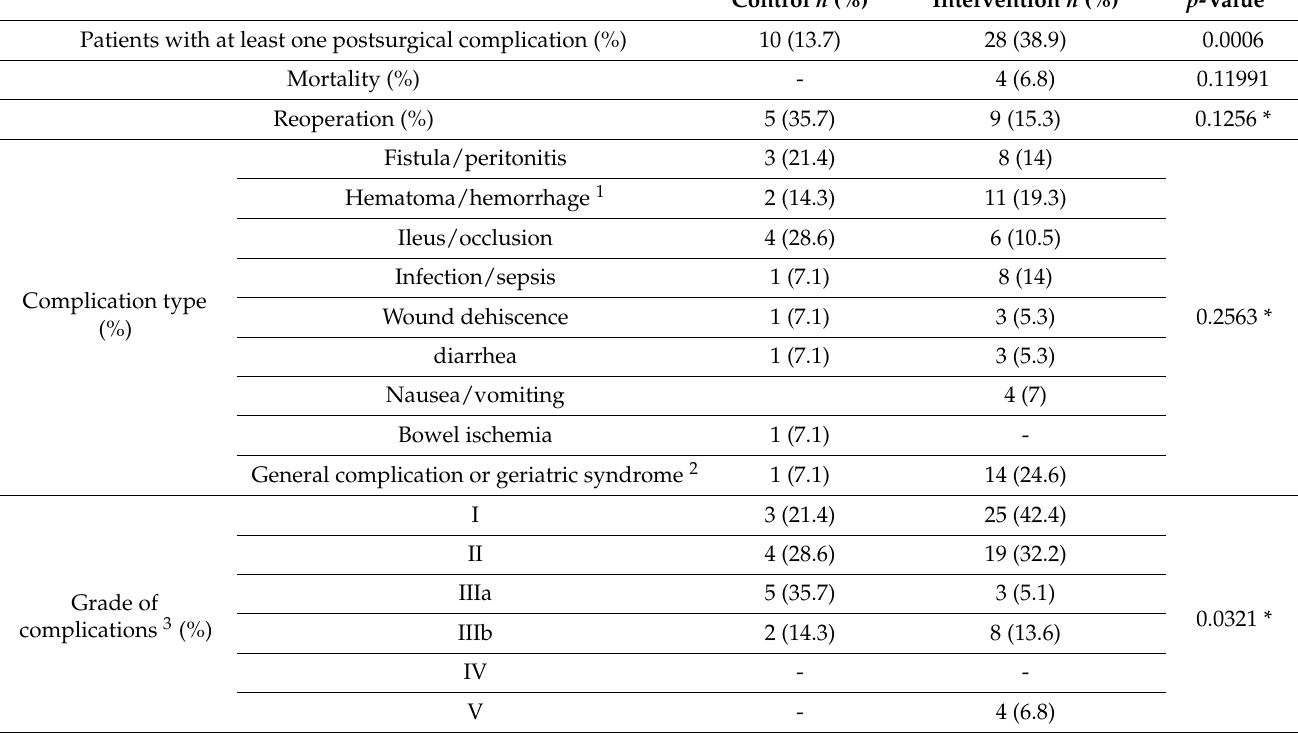
Table 4. Thirty-day postsurgical complications in both groups (N =